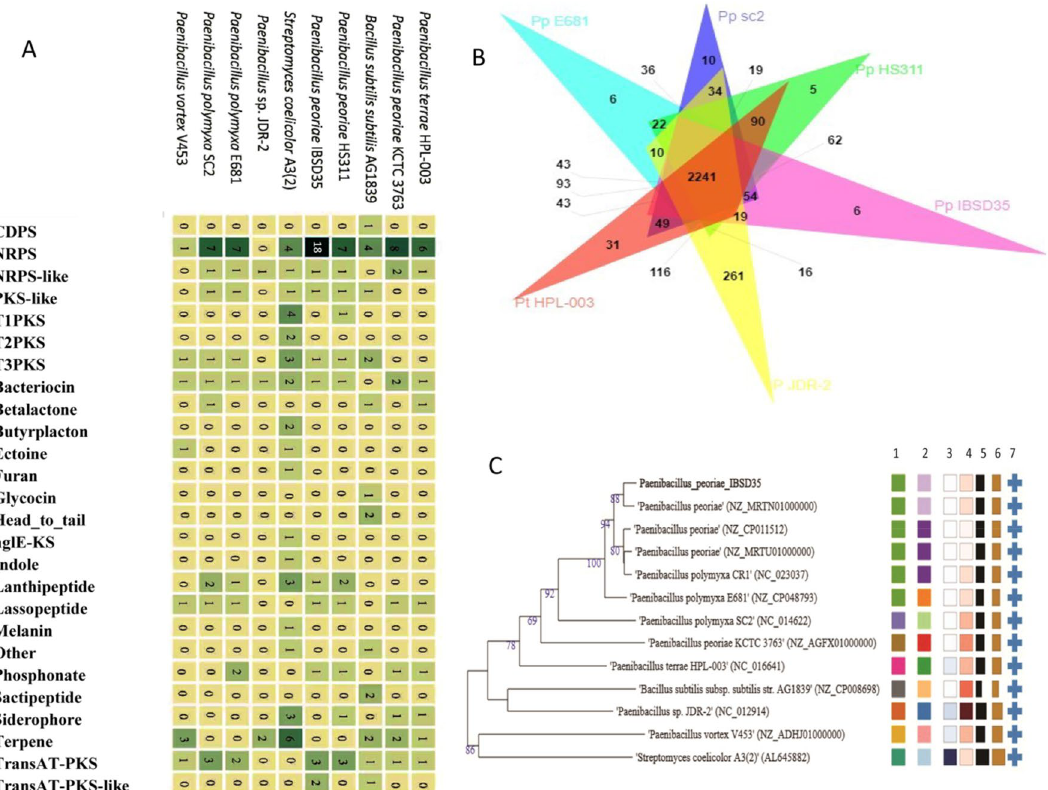
Figure 6. ( A ) The Heatmap of the BGCs of the selected genome. The names of the genomes are indicated on the left side. The rows represent the genomes BGCs, and its columns indicate the type of BGC. The BC types are indicated in description on bottom. Cells are colored with hues of green based on the number of copies of the selected protein family (Pfam) in the BC (numbers of BCs are indicated in numbering). Pfams (columns) that occur in all BCs (rows) define the core functions. ( B ) Venn diagram for the comparison of six closely related strains. ( P. terrae HPL-003(NC_016641), P. peoriae HS311 (NZ_CP011512), P. peoriae IBSD35 ( NZ_ PTJM01000000 ), Paenibacillus sp. JDR-2 (NC_012914), P. polymyxa E681(NZ_CP048793), and P. polymyxa SC2 (NC_014622). They formed 5615 clusters, 5296 orthologous clusters, and 2125 single-copy gene clusters. They shared 2241 gene clusters. 6-clusters are specific to P. peoriae IBSD35. ( C ) Tree inferred with FastME 2.1.6.1 114 from GBDP distances calculated from genome sequences. P. peoriae IBSD35 has a dDDH of (d4) 76.1, (C.I.) d4 of [73.1–78.9], and a difference G + C% of 0.16 with P. peoriae HS311 indicating their close species relation. The branch lengths are scaled in terms of GBDP distance formula d5. (Leaf labels are annotated by affiliation to species (1) and subspecies (2) clusters, genomic G + C content (3), δ values (4), overall genome sequence length (5), number of proteins (6), and the kind of strain (7). User-provided GenBank accession IDs are shown in parentheses; master record accessions are truncated (Percent G + C—43.5–72.1, No of